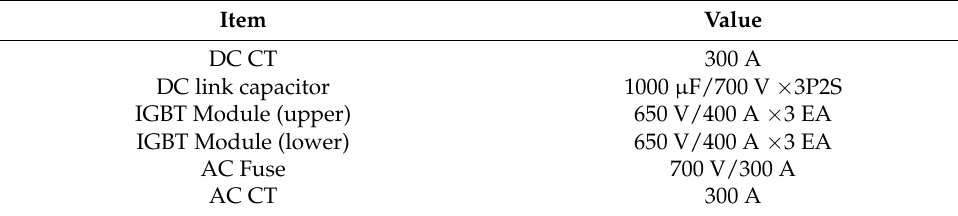
Table 7. Rating of the major parts for the 500 kW inverter panel.